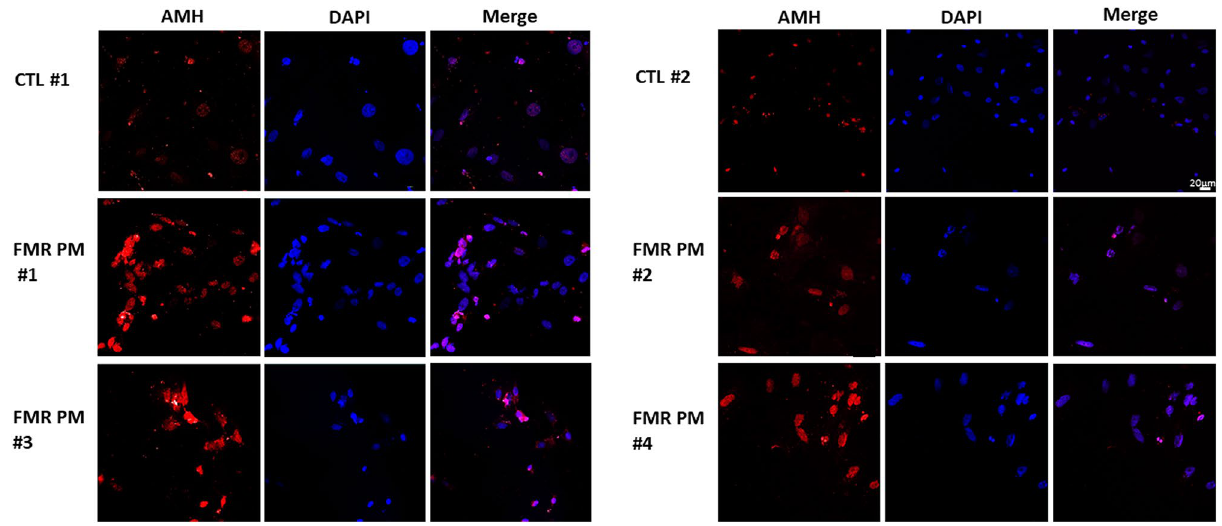
Figure 2. Higher AMH protein expression in MCGs of FMR1 premutation carriers compared to MGCs of noncarriers. Fixated and stained MGCs from FMR1 premutation carriers ( FMR PM #1–4) displaying higher AMH expression compared to noncarriers (CTL #1–2). Bar = 20